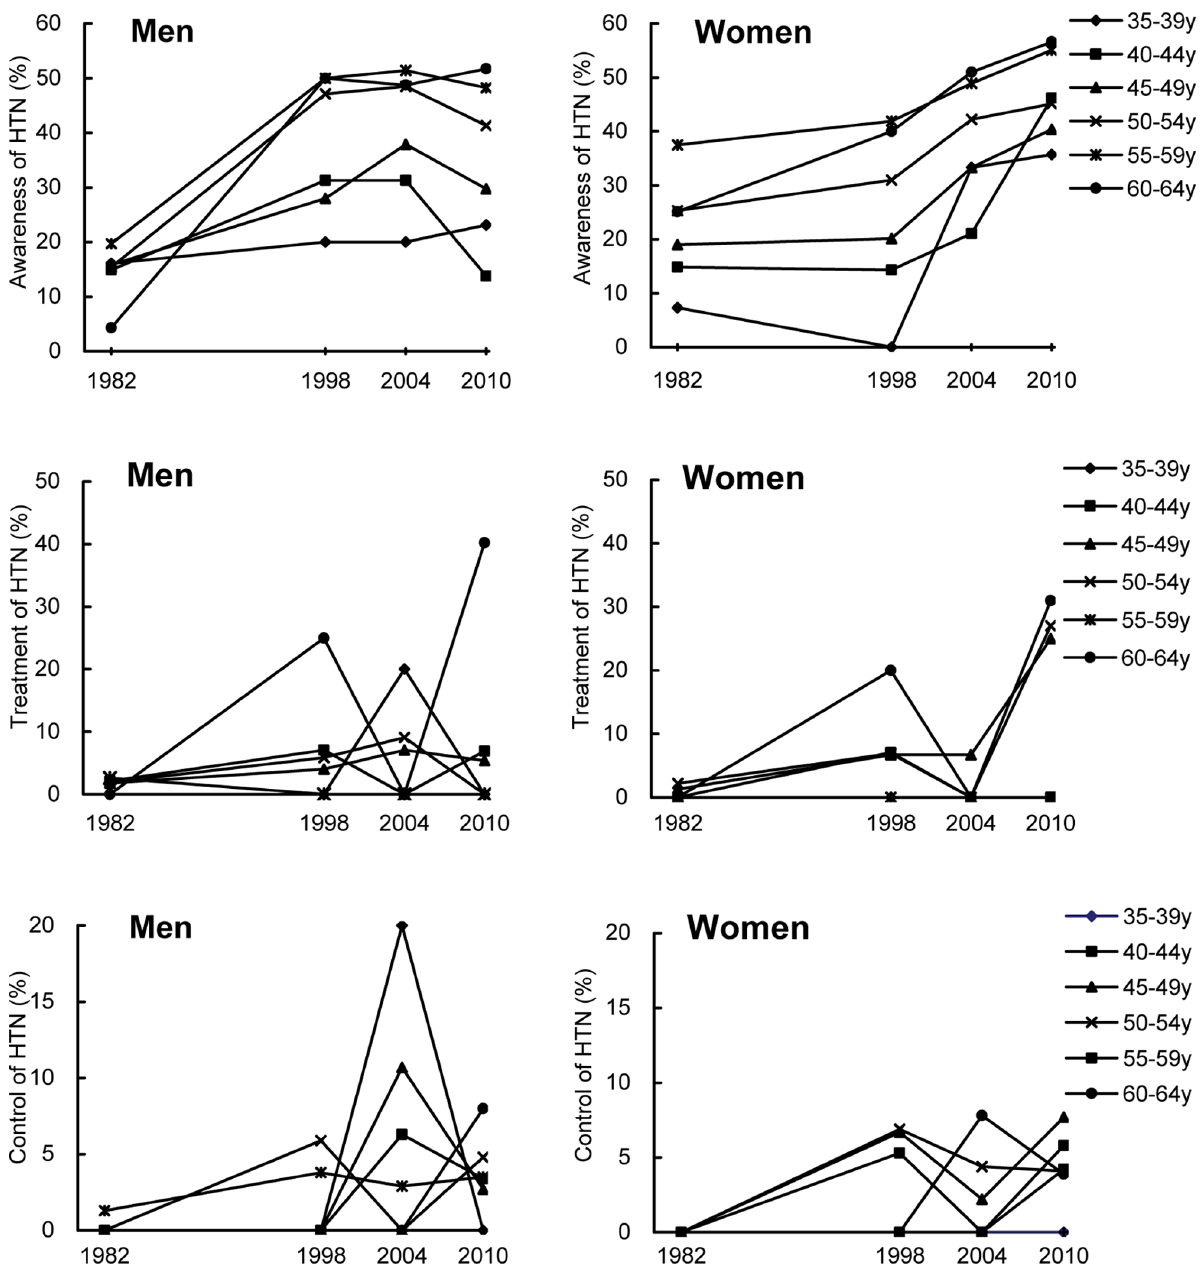
Figure 4. Trends in awareness, treatment, control of HTN among adults in different sex and age group, 1982 to 2010.